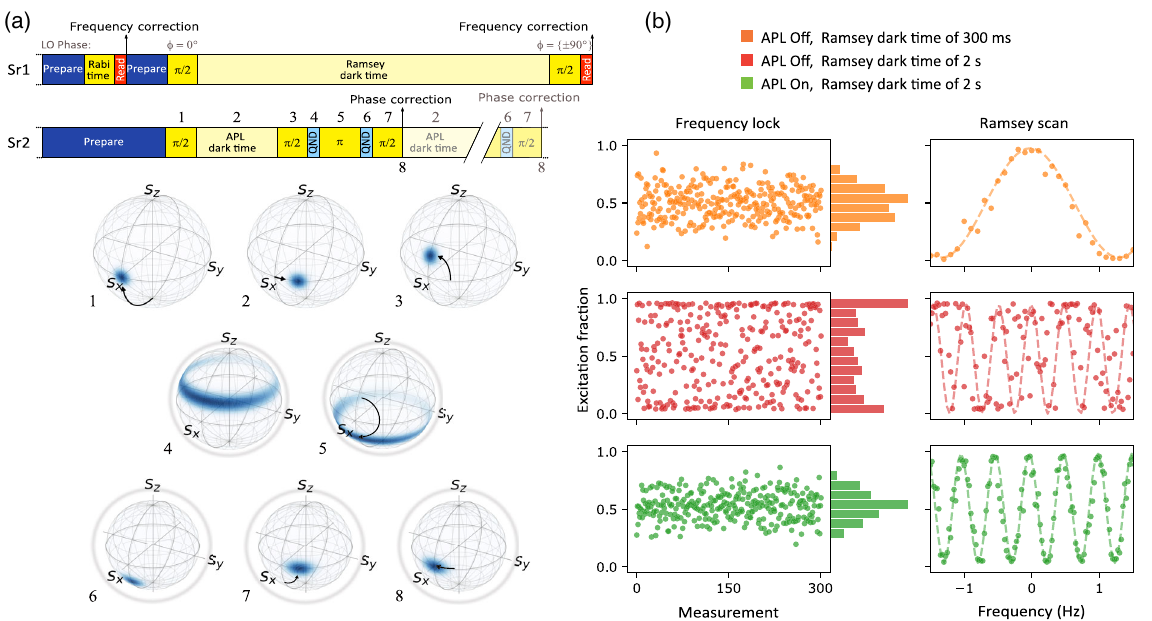
FIG. 4. Enhanced Ramsey spectroscopy via APL. (a) Timing sequence for the synchronous spectroscopy scheme, and Bloch sphere representation of the atomic state during the APL sequence. Atomic data from the Rabi time in Sr1 are used only when scanning over Sr1 Ramsey fringes. Prior to and during each scan, the Rabi data measure frequency drift of the free-running LO (typically between 0 and 3 mHz s − 1 ), and allows us to apply LO drift compensation in a double-integrator control loop with attack time of approximately 100 clock cycles. (b) Results using Ramsey spectroscopy in Sr1, cointerrogated with Sr2 using the same LO. Left: excitation fractions with the LO frequency locked to the central Sr1 Ramsey fringe under three conditions: 300 ms Ramsey dark time with the APL to Sr2 disengaged (orange), 2 s dark time with the APL disengaged (red), and 2 s dark time with the APL engaged (green). Frequency scans over the Sr1 Ramsey fringes are shown on the right under the same conditions as above. With the APL engaged, the fringe width is measured to be 254(1) mHz for a 2 s dark